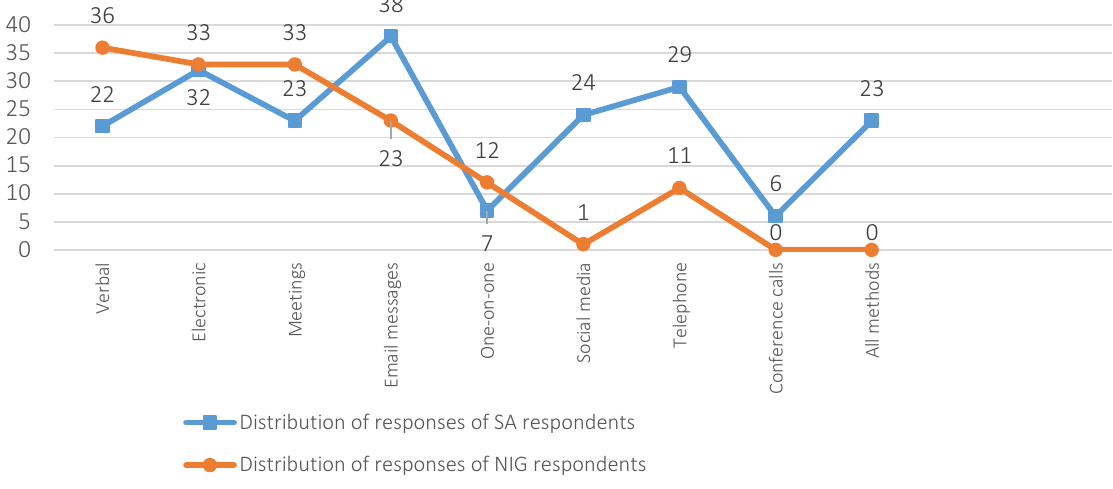
Figure 2. Communication channels for facilitating the introduction of innovative